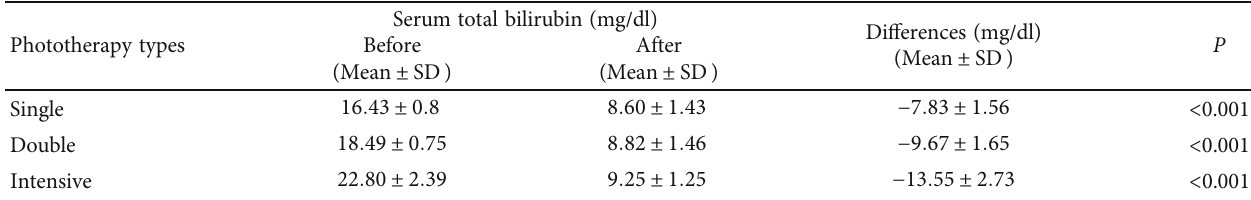
Table 2: Total serum bilirubin levels before and after single, double, and intensive phototherapy. Phototherapy types